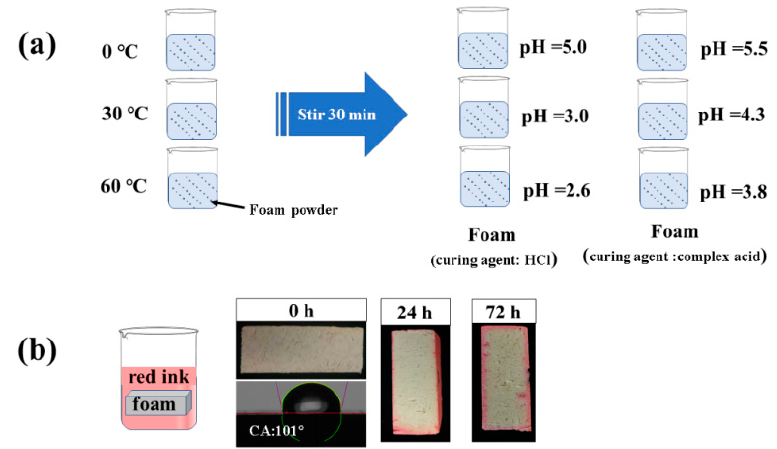
Figure 8. ( a ) Determination of foam acidity and ( b ) foam hydrophobicity test of FTPF.